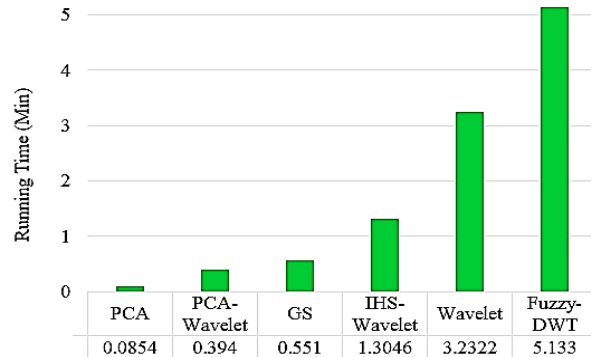
Figure 7. The time consumed by each pan-sharpening algorithm